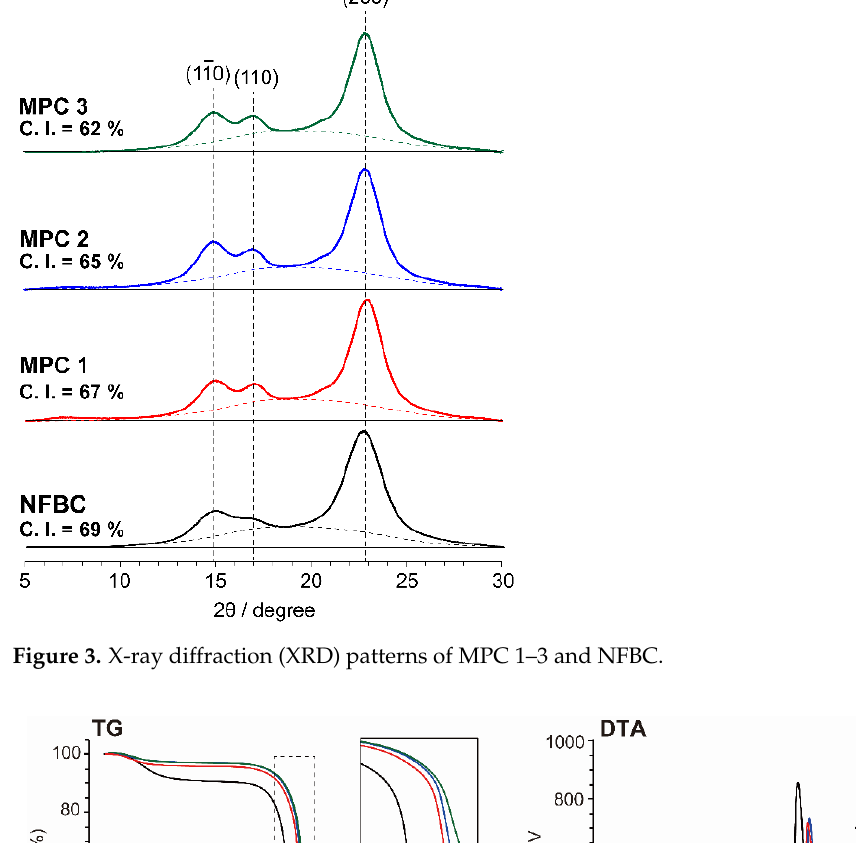
Figure 5. SEM images of NFBC and MPC 1 ‒ 3.